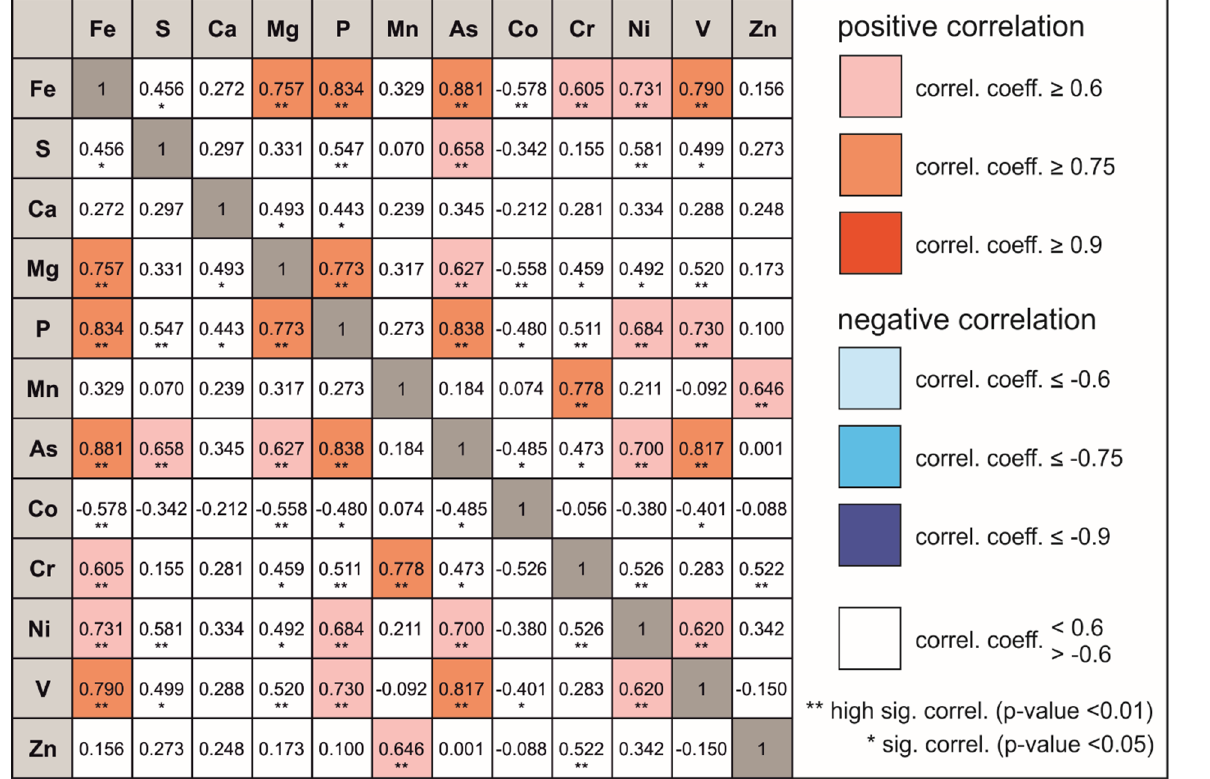
Figure 4. Spearman element correlation matrix for 25 samples of the Tertiary.